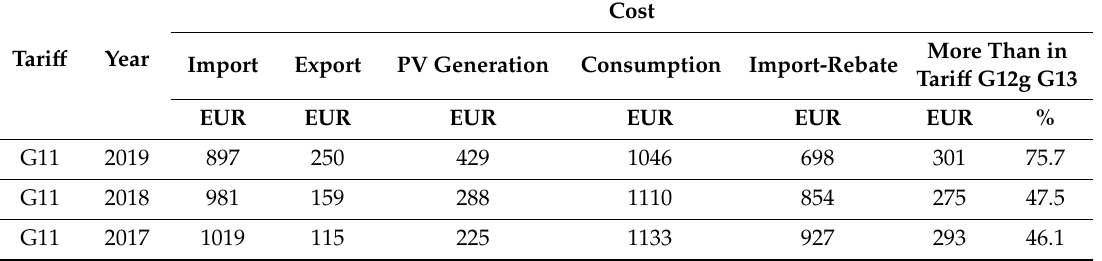
simply to G11 tari ff